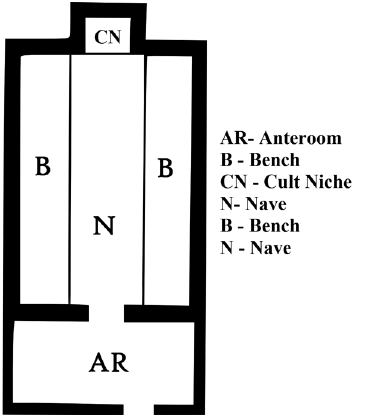
Figure 1: The standard plan of a